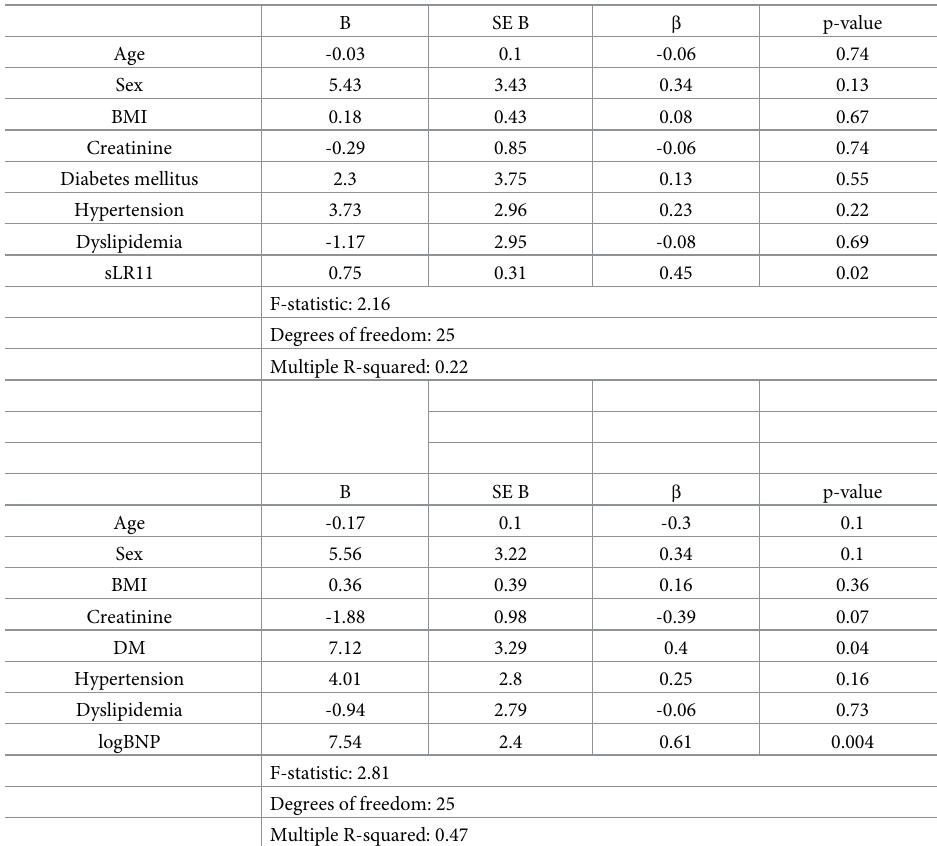
Table 2. Multivariate analysis of factors associated with mPAP.